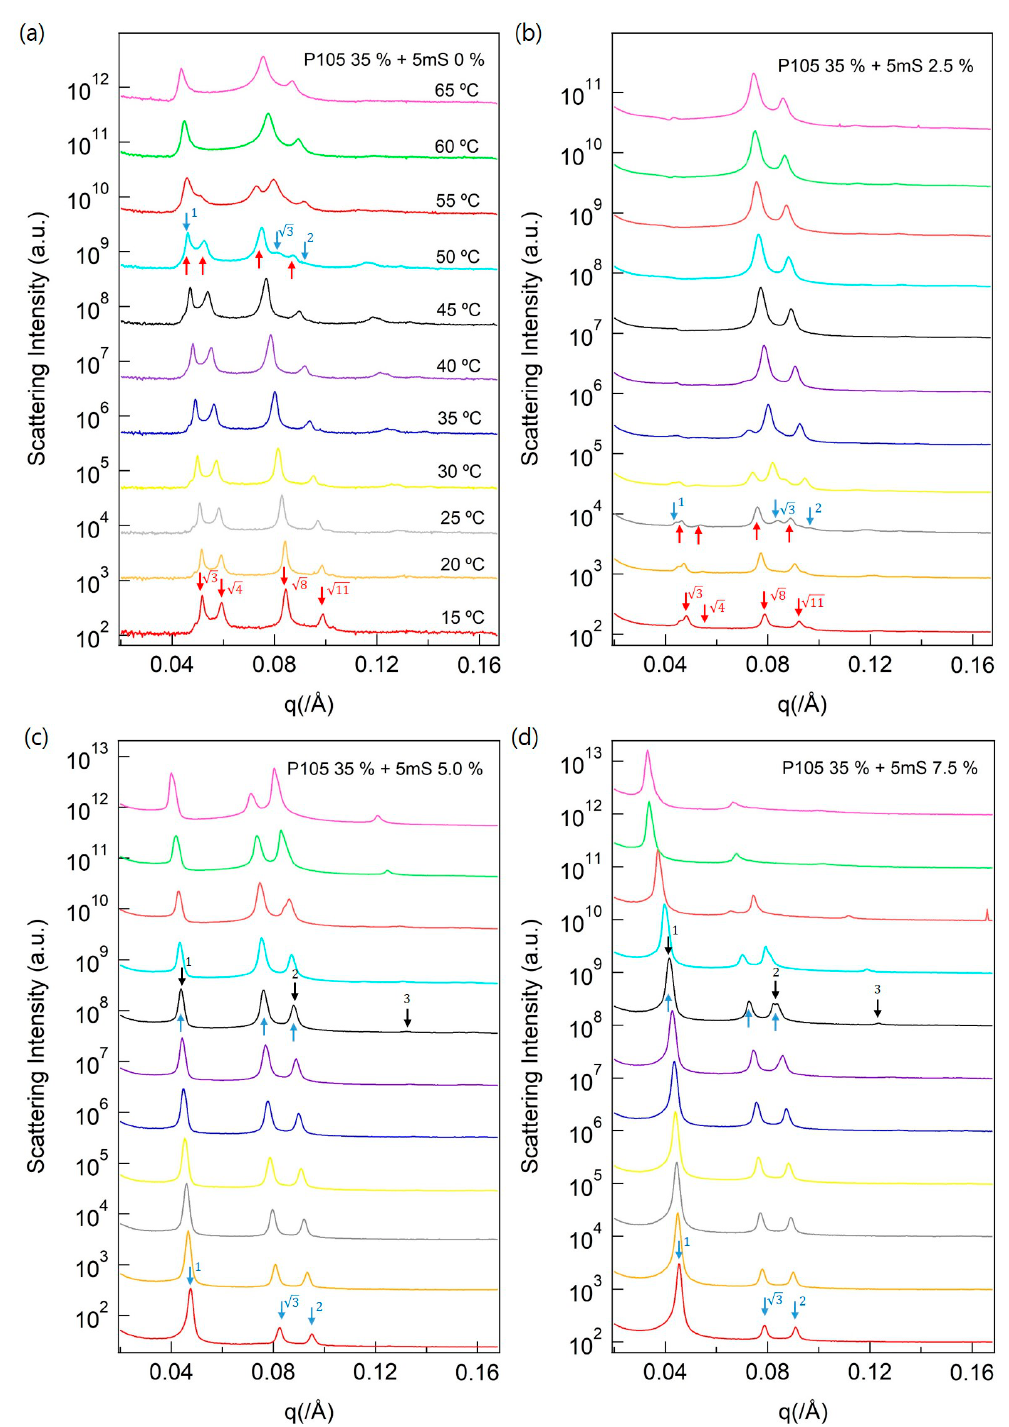
Figure 2. Small-angle X-ray scattering (SAXS) intensities of the P105-5mS complex in aqueous solution. The complexes of ( a ) P105 35%-5mS 0.0 %, ( b ) P105 35%-5mS 2.5 %, ( c ) P105 35%-5mS 5.0 %, and ( d ) P105 35%-5mS 7.5 % were conducted depending on a various temperature. The red, light blue, and black arrows indicate the SAXS signals of the FCC, hexagonal, and lamellar phases, respectively.